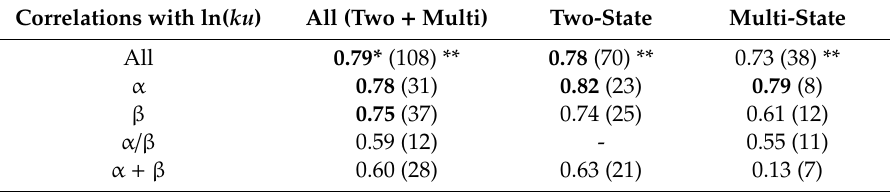
Table 1. Correlations between logarithm of unfolding (ln( ku ) and folding (ln( kf ) rates for four structural classes of proteins α , β , α / β and α + β . Correlations with ln( ku ) All (Two + Multi) Two-State Multi-State All